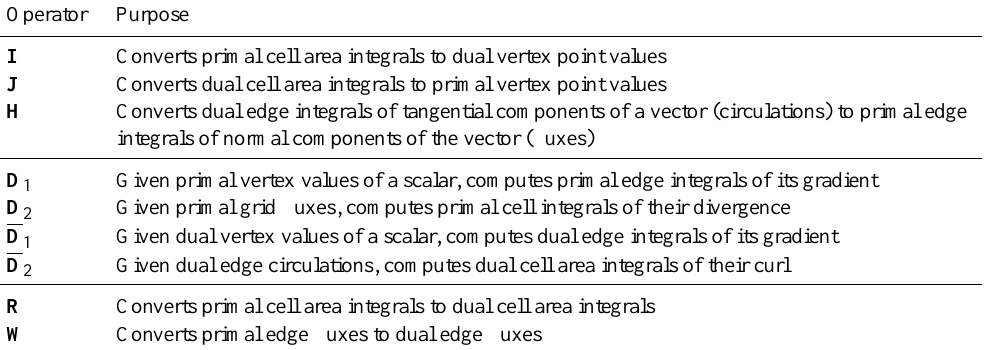
Table 3. Summary of mimetic